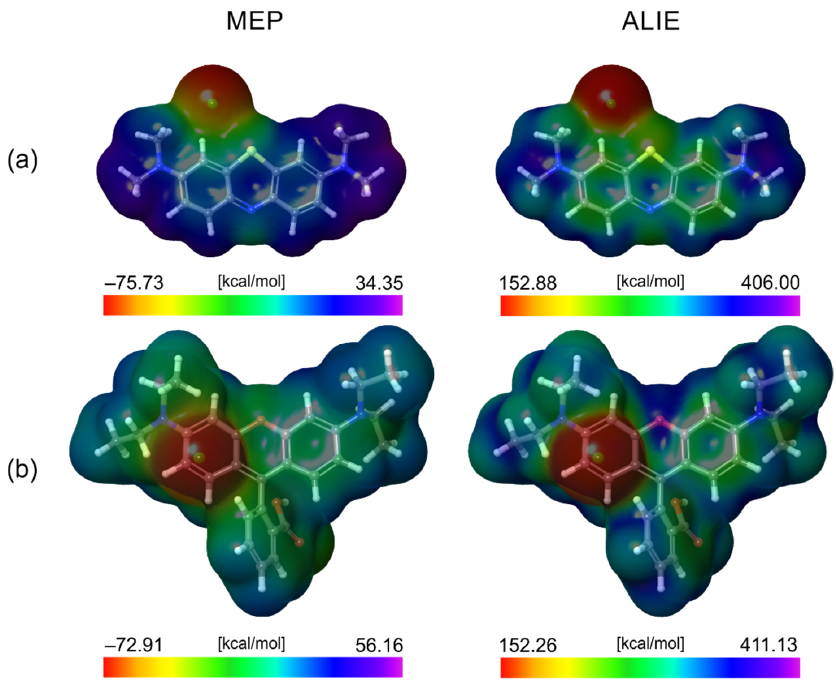
Figure 14. MEP and ALIE surfaces of ( a ) MB and ( b ) RB dyes.